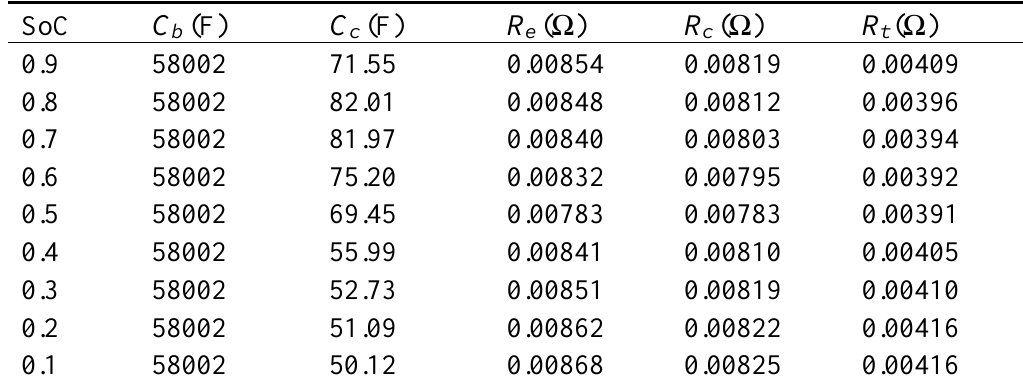
Table 2. Optimized parameters of the battery model.